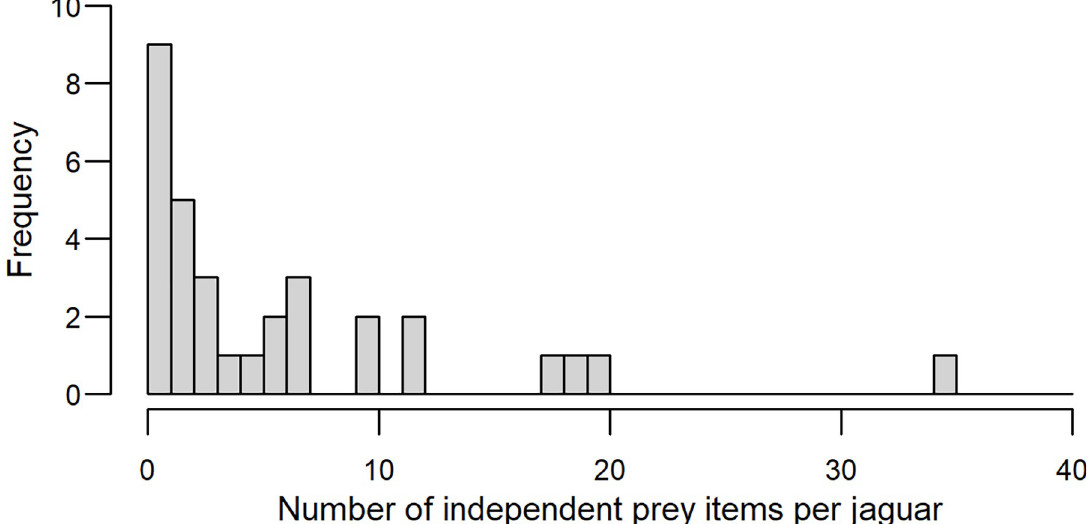
Fig 1. Frequency distribution of prey items per jaguar. N = 206 independent prey items from 32 jaguars; scats collected from 2003 to 2006 in and around the Cockscomb Basin Wildlife Sanctuary, Belize.